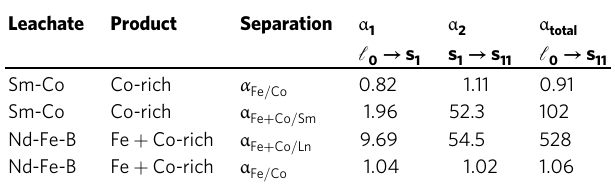
Table 2 Separation factors for staged treatments of the Sm- Co magnet leachate and the Nd-Fe-B mixed magnet leachate at 25 °C as depicted in Fig.